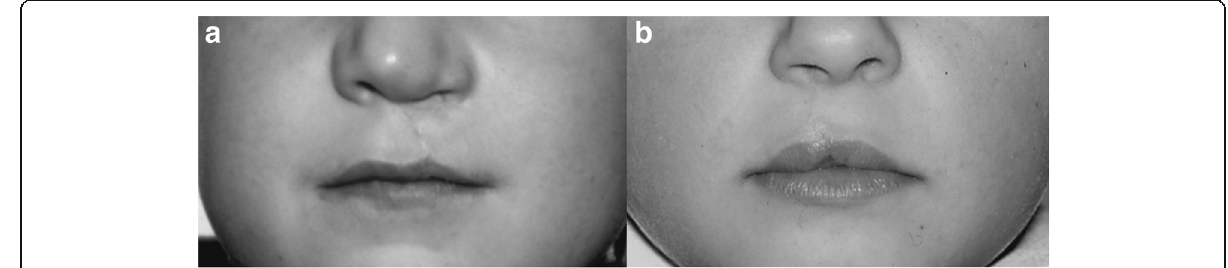
Fig. 7 Postoperative results. a Clinical result 6 years postoperative after lip closure according to Millard. b Clinical result 6 years postoperative after lip closure according to